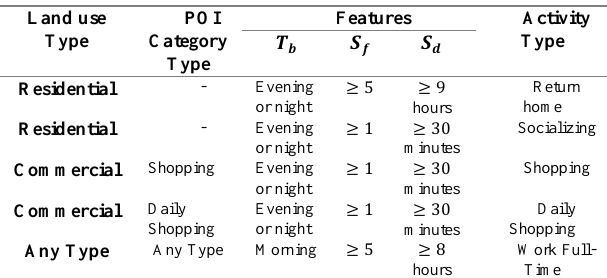
Table 1. Axioms associated to activity types.